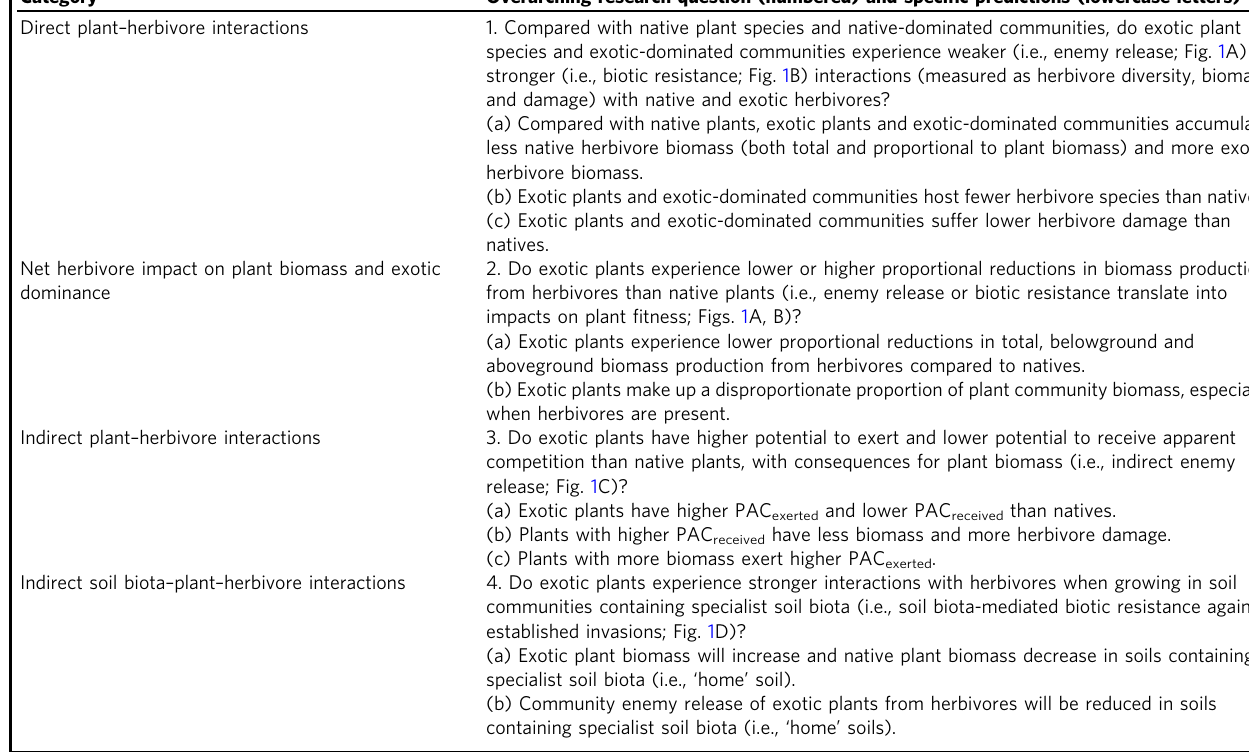
Table 1 Overarching research questions and speci fi c predictions tested using our mesocosm experiment. Category Overarching research question (numbered) and speci fi c predictions (lowercase letters) Direct plant – herbivore